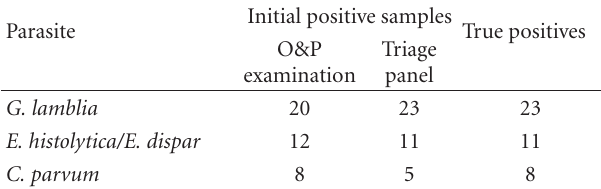
Table 1: Comparison of the Triage Micro Parasite Panel and O&P examination results for diagnosis of Entamoeba histolytica/E. dispar , Cryptosporidium parvum, and Giardia lamblia in 266266 stool samples. Results comparing the Triage Micro Parasite Panel and O&P examination in 266 stool samples. The true positive results were determined after discrepant samples were analyzed. For G. lamblia , there were three false-negative results by O&P examination. For E. histolytica/E. dispar , there was one false-positive result by O&P examination. For C. parvum , there were three false-negative results by the Triage Micro Parasite Panel. Additional parasites detected by O&P examination were Ascaris lumbricoides ( n = 3), Entamoeba coli ( n = 2), Chilomastix mesnili ( n = 1), and Hymenolepis nana ( n =